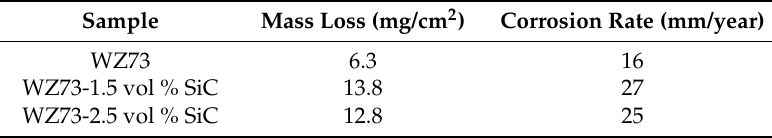
Figure 6. Marco corrosion morphologies of the WZ73 alloy, WZ73-1.5 vol% SiC, and WZ73-2.5 vol% SiC composites immersed in 1 wt % NaCl solution for 1, 12 and 24 h. Table 4. Corrosion rate of WZ73 and MMCs obtained from mass loss after immersing in a 1 wt % NaCl solution for 24 h.